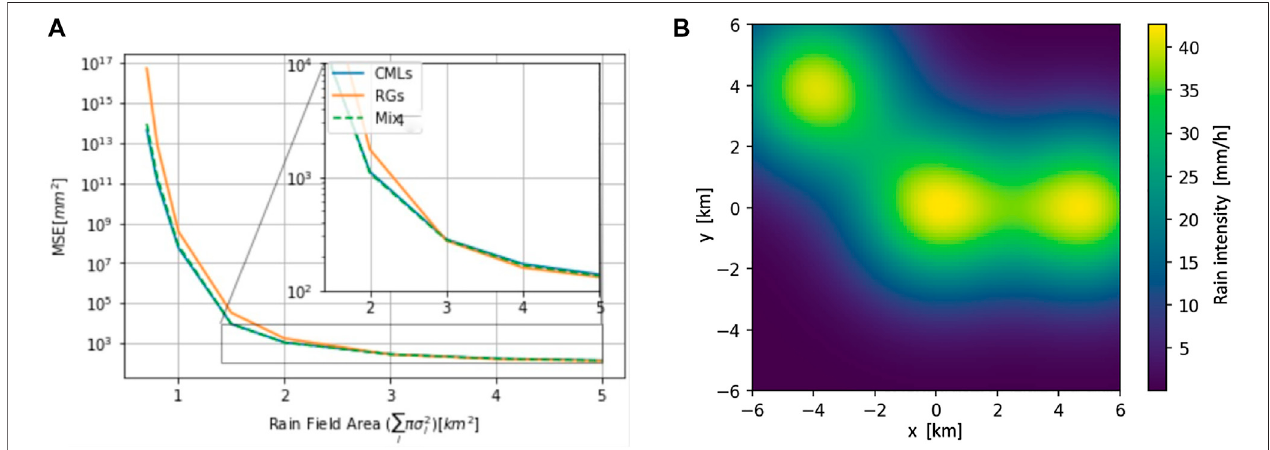
FIGURE 6 | CRB on the spatial MSE as in Figure 5 (A) for multiple rain cells, as in (B) . (A) presents the spatial MSE over the rain fi eld area, which is the sum of cell sizes, and (B) presents the assumed rain fi eld with three cells.